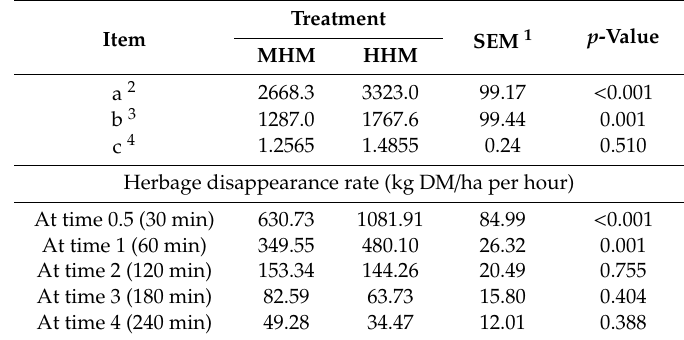
Table 4. Coe ffi cients of the model used to characterize the grazing-down process and herbage disappearance rate in a pasture with a medium (MHM) and high (HHM) pre-grazing herbage mass grazed by dairy